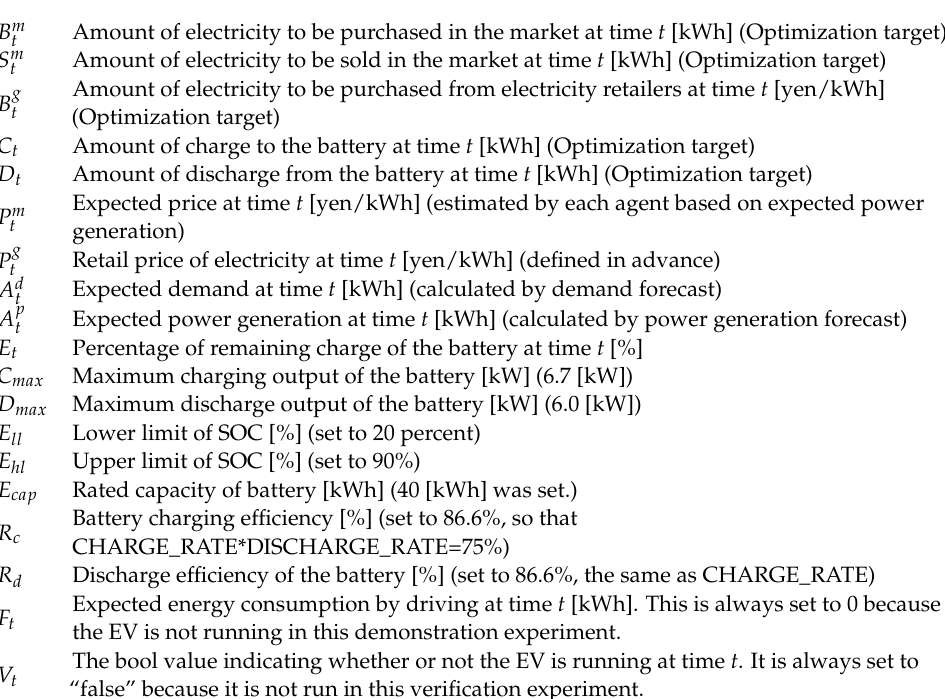
Table 1. Price table of 𝐺𝑟𝑖𝑑𝑃𝑟𝑖𝑐𝑒 (cid:3047) .